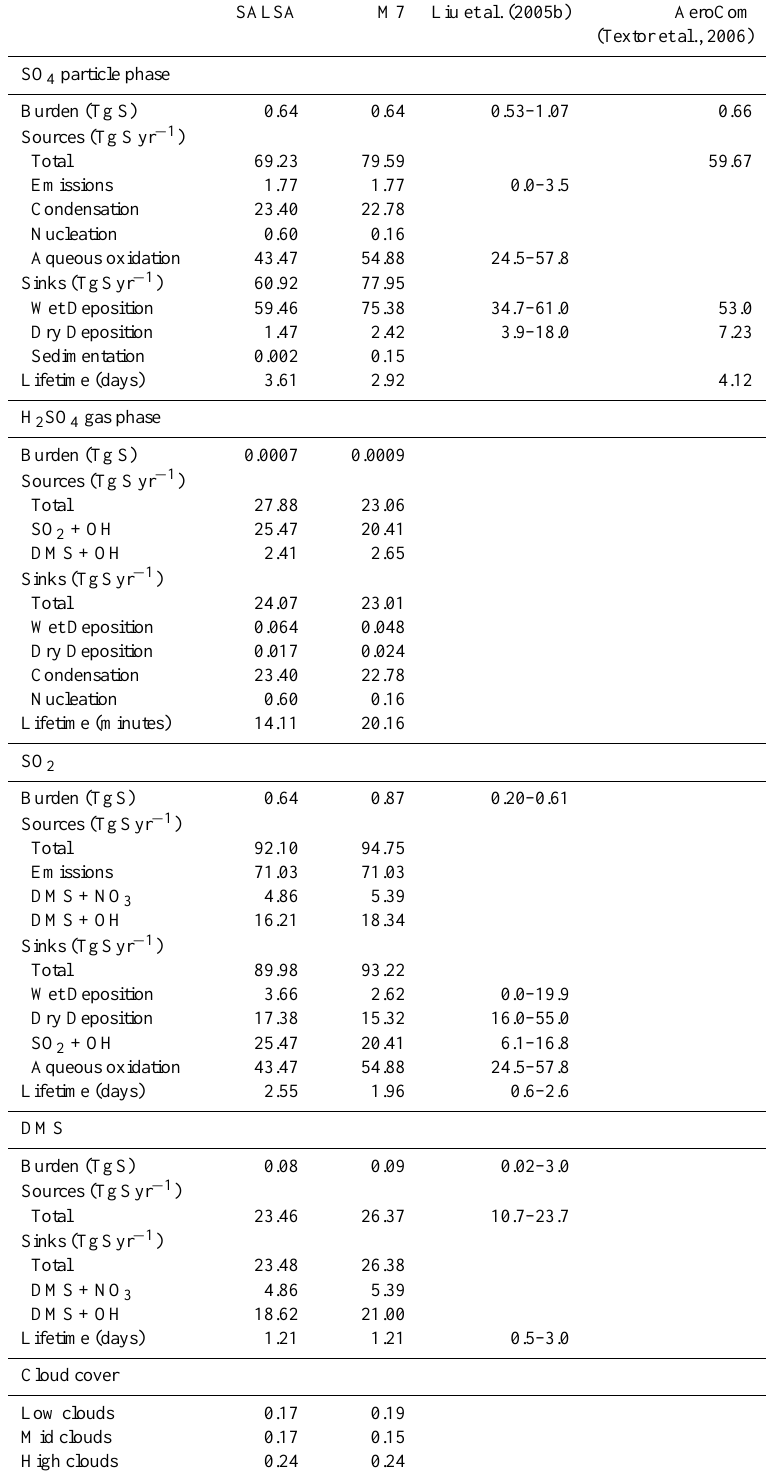
Table 6. Annual mean global sulphur cycle calculated using SALSA and M7 as well as results found in the literature. Additionally,